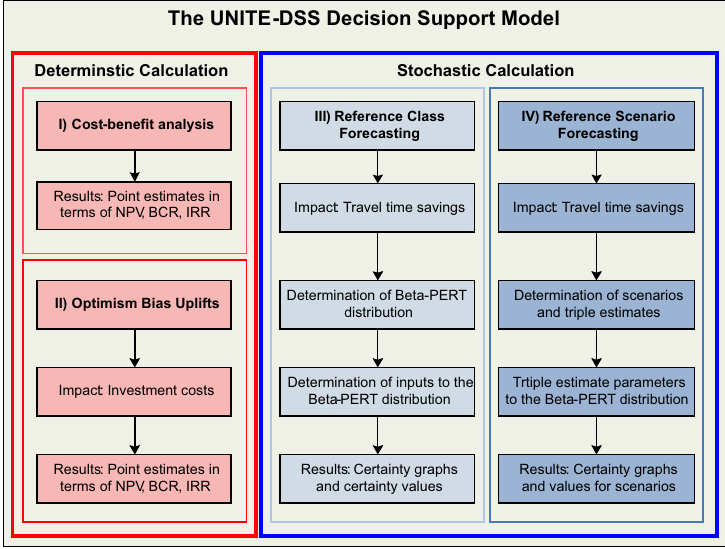
Fig. 2. Calculation procedure for the UNITE-DSS model for feasibility risk assessment